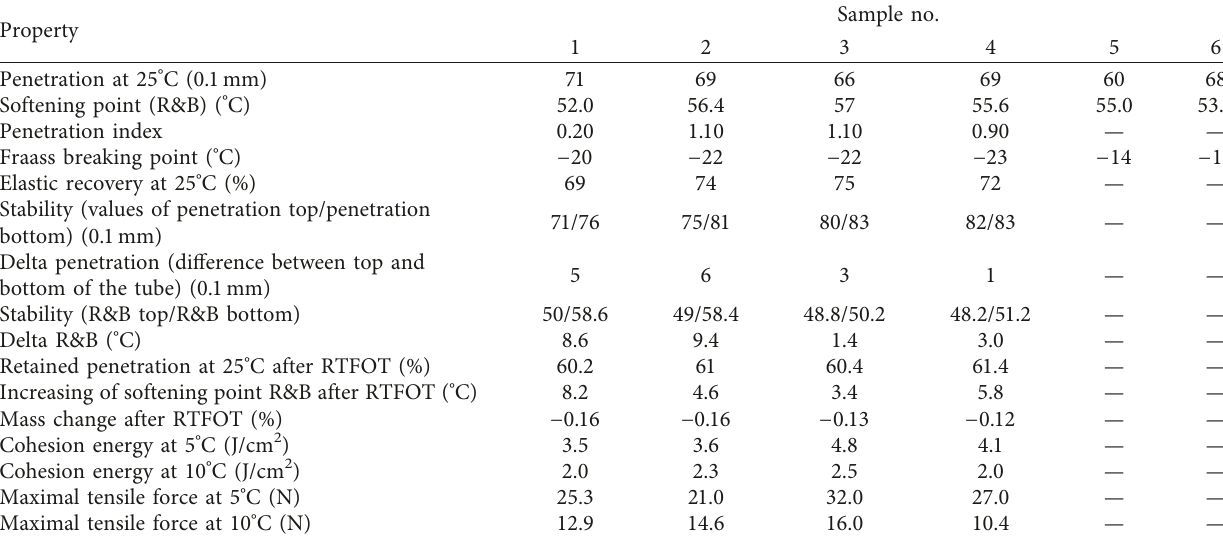
Table 3: Properties of bitumen modified at 190 ° C.